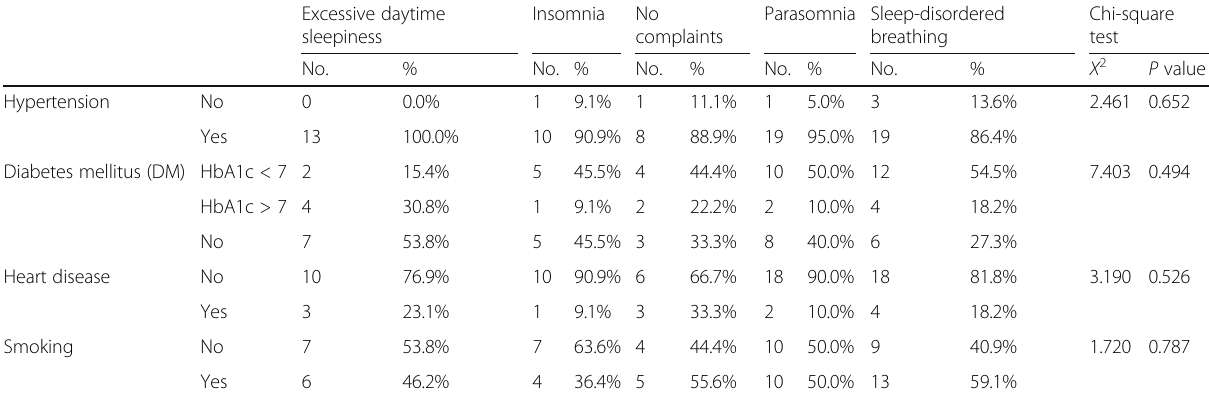
Table 3 Statistical correlations between sleep disorders after stroke and stroke risk factors Excessive daytime sleepiness